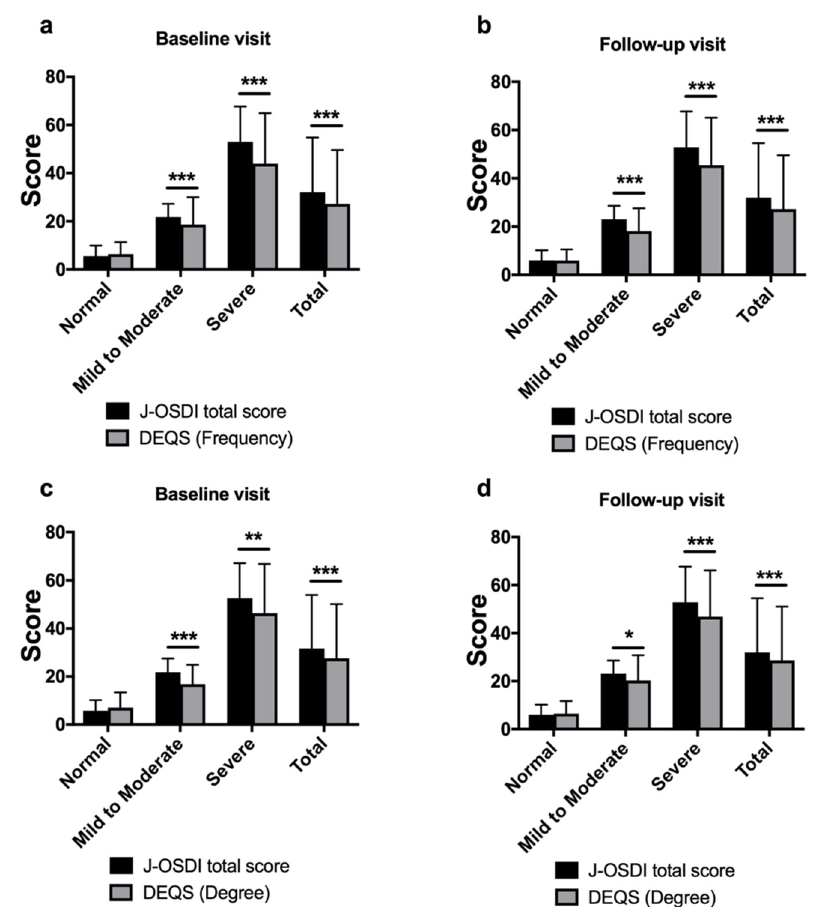
Figure 3. Comparison of the J-OSDI total score and DEQS (Frequency and Degree) of patients with dry eye disease based on the J-OSDI subgroups; ( a , b ) show the comparison between the J-OSDI total score and DEQS (Frequency) based on the J-OSDI subgroups at baseline ( a ) and follow-up ( b ) visits, and ( c , d ) show the comparison between the J-OSDI total score and DEQS (Degree) based on the J-OSDI subgroups at baseline ( c ) and follow-up ( d ) visits. Data are considered statistically significant at * p < 0.05, ** p < 0.01, and *** p < 0.001.